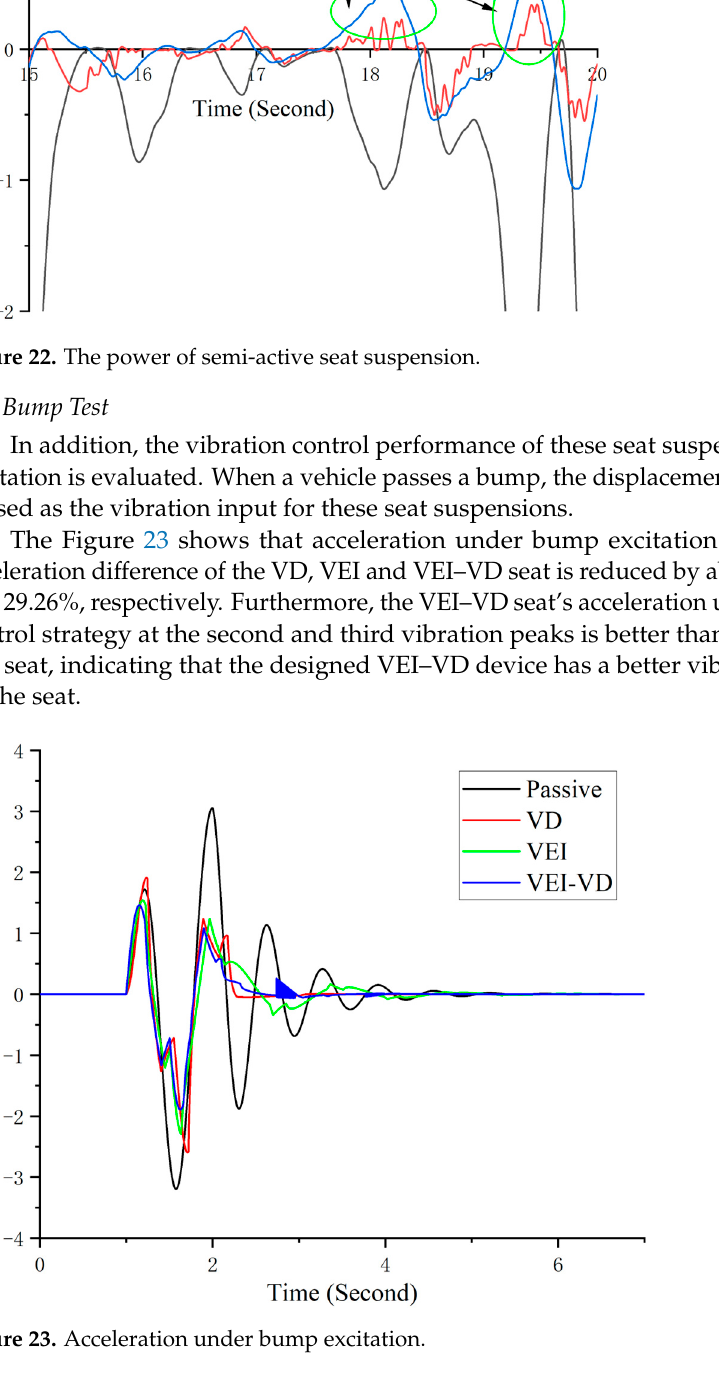
Figure 21. The resistance of VEI–VD device.